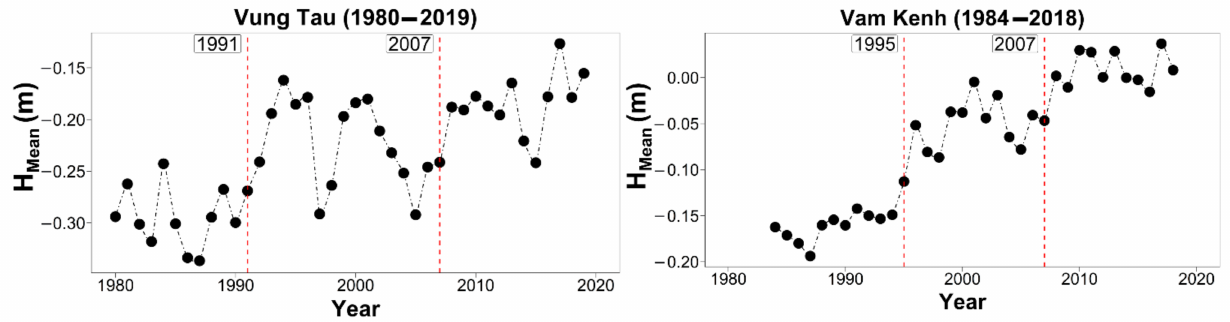
Figure A6. Changepoint years showing the possible shifts in H min